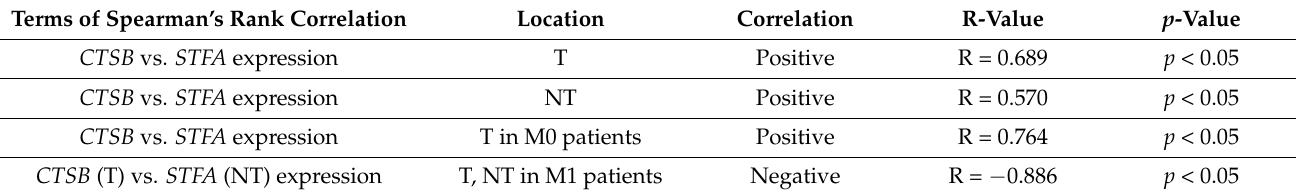
Table 1. Spearman’s rank correlation of CTSB and STFA mRNA expression with clinical and patho- logical features of human renal cell carcinomas.